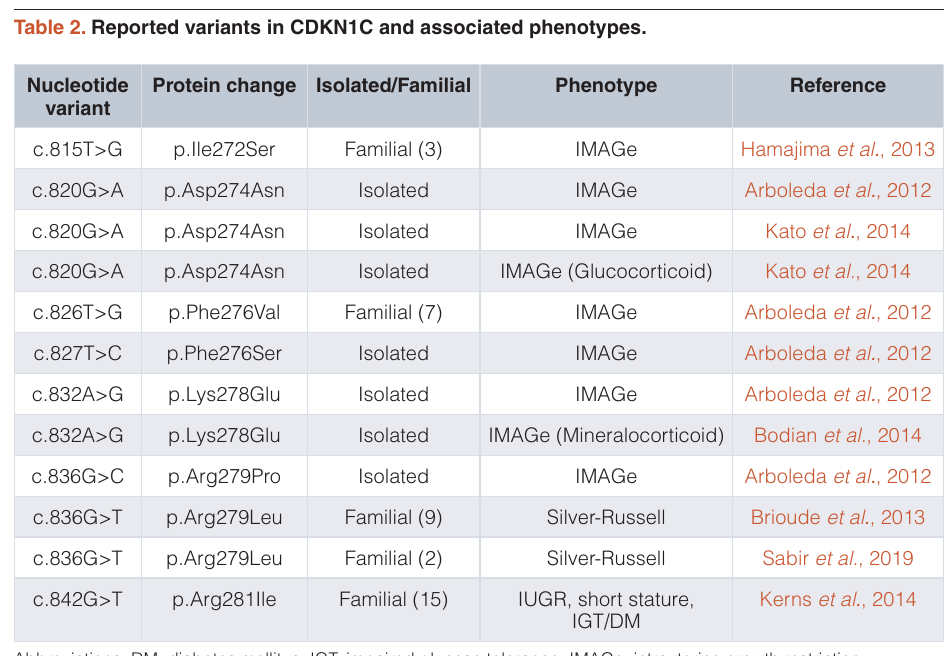
Variants in CDKN1C associated with familial Silver-Russell syndrome or growth restriction but normal adrenal function were found towards the carboxyl-terminal region of this “hot-spot” domain (p.Arg279Leu, p.Arg281Ile) (Figure